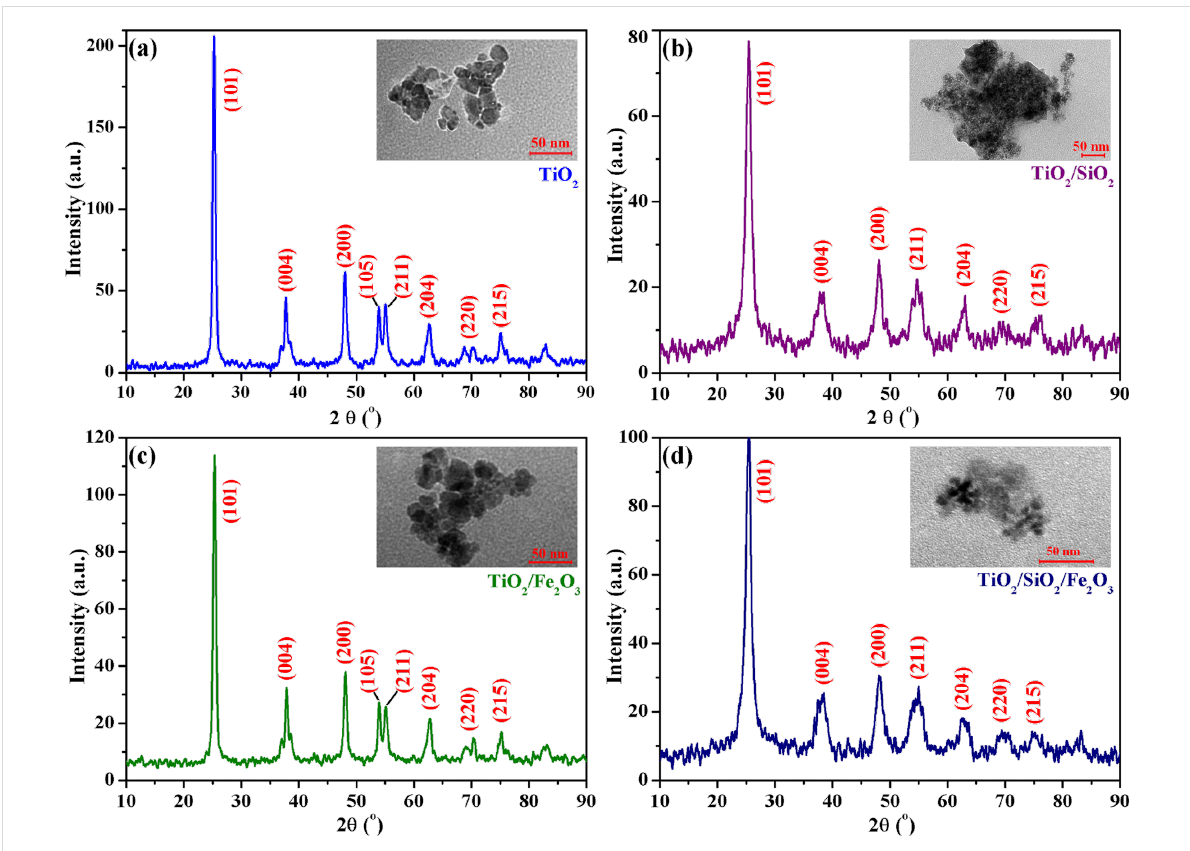
Figure 1: XRD patterns and TEM images (inset) for (a) TiO 2 , (b) TiO 2 /SiO 2 , (c) TiO 2 /Fe 2 O 3 and (d) TiO 2 /SiO 2 /Fe 2 O 3 nanopowders.